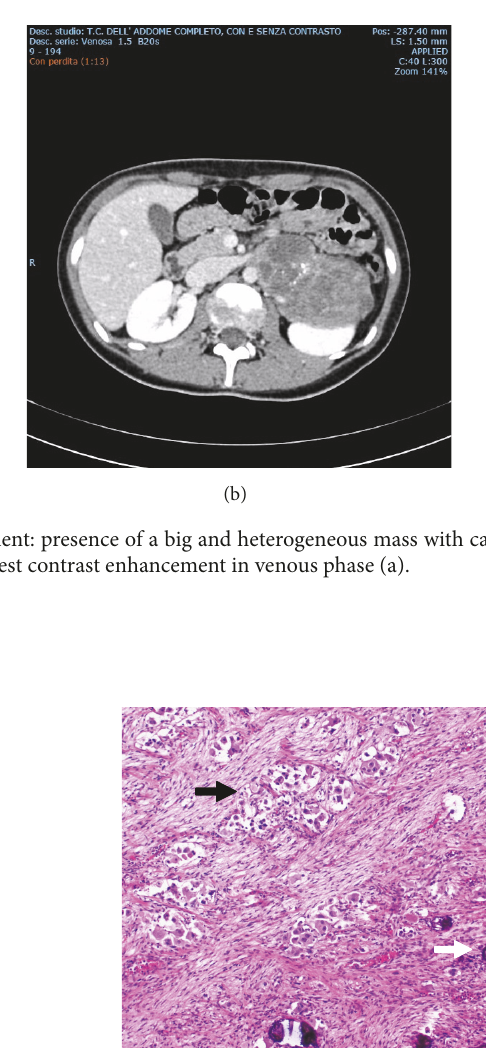
Figure 2: Histological examination (hematoxylin and eosin stain, 10x): high proportion of ganglion cells (black arrow) in spindle stroma and dystrophic calcification (white